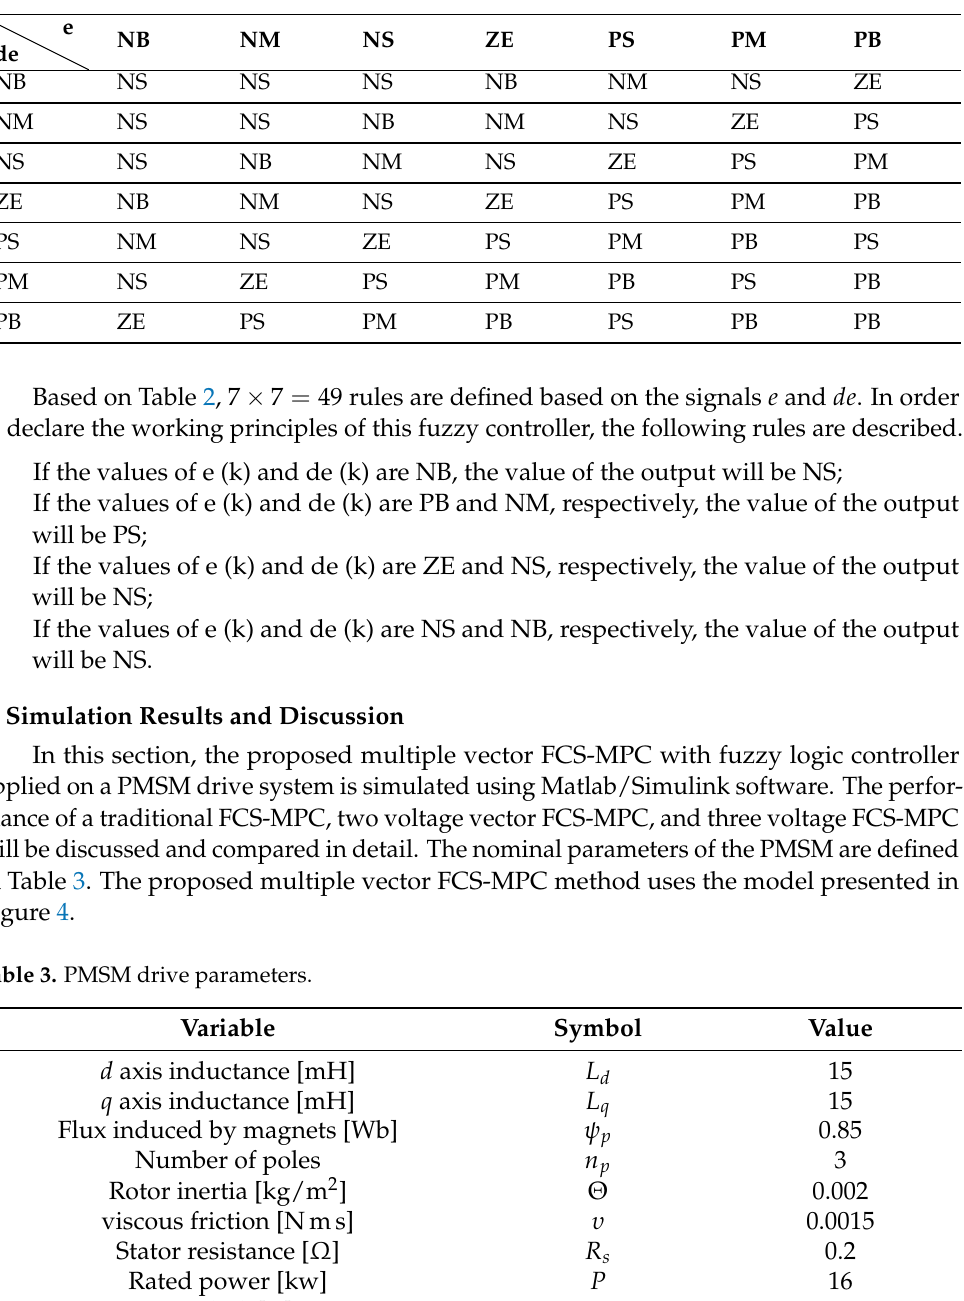
Table 2. Rule base for speed control. Negative big (NB), negative medium (NM), negative small (NS), zero (ZE), positive small (PS), positive medium (PM), and positive big (PB).